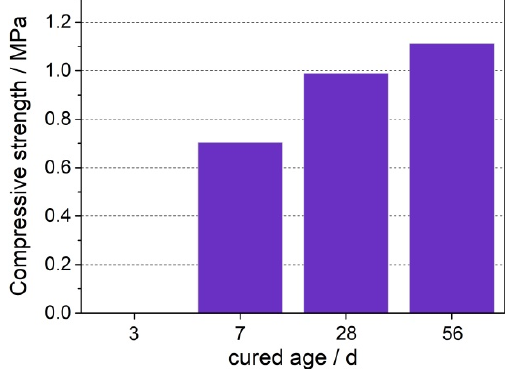
Figure 5. Self-hardening compressive strength of LCFA.